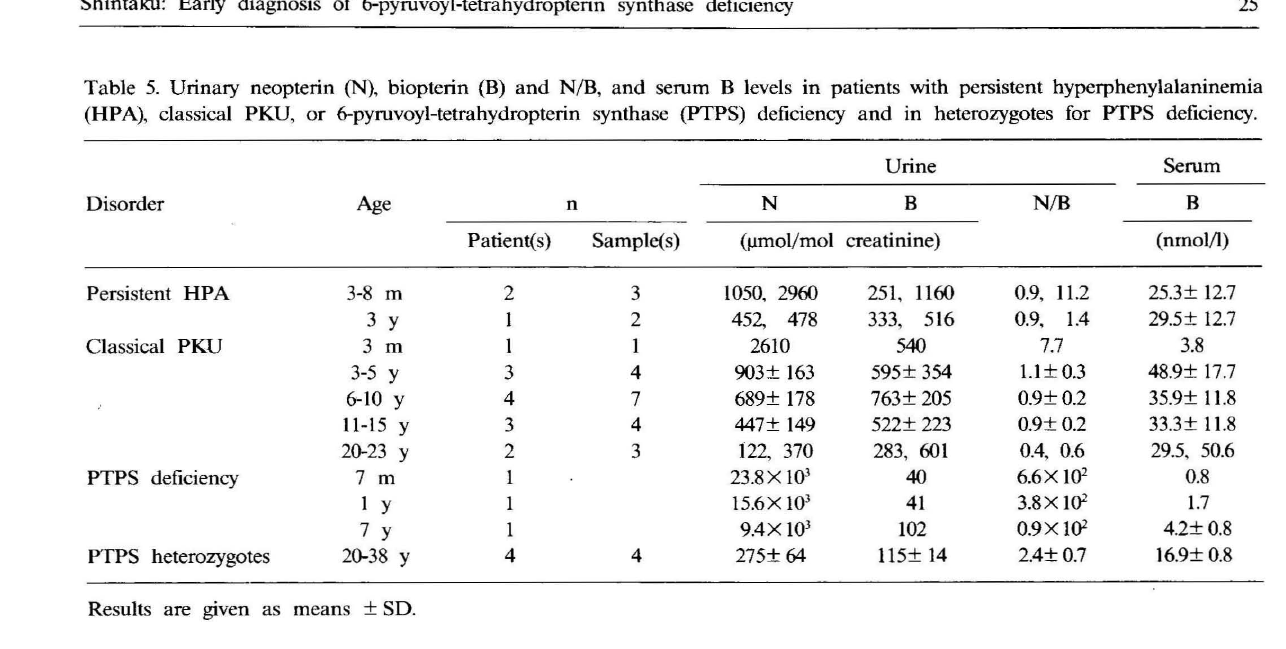
Table 5. Urinary neopterin (N), biopterin (B) and NIB, and serum B levels in patients with persistent hyperphenylalaninemia (HPA), classical PKU, or 6-pyruvoyl-tetrahydropterin synthase (PTPS) deficiency and in heterozygotes for PTPS deficiency.